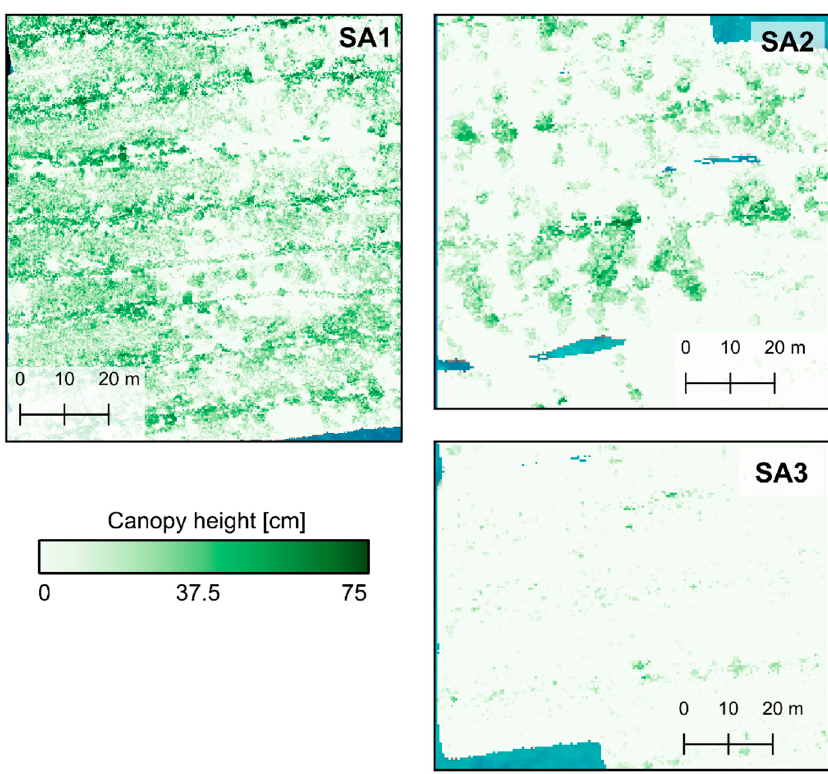
Figure 6. Modeled CHMs for the three analysed subareas SA1, SA2, and SA3, the maximum derived canopy heights vary between 0.49 m and 0.77 m. Gaps occur between the MBES tracklines with no overlap.